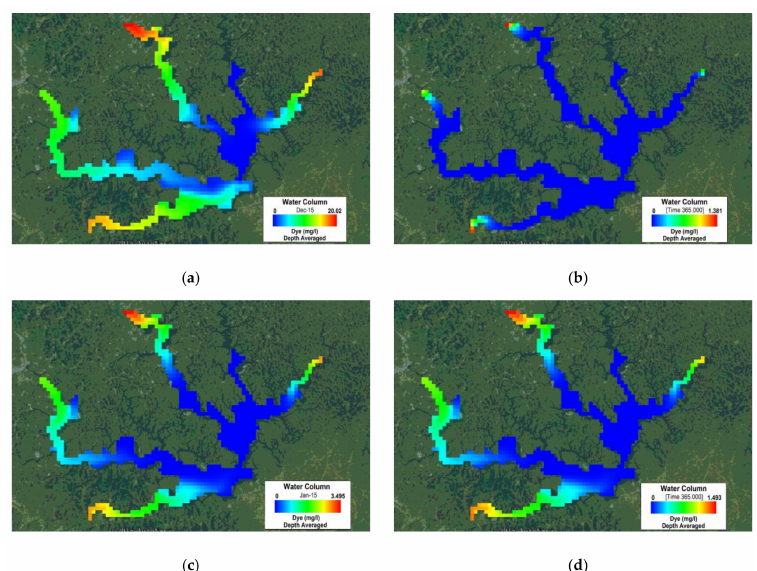
Figure 4. The simulated concentration distribution of COD, NH 3 -N, TN, and TP in the Huangshi Reservoir in 2020. (( a ) COD, ( b ) NH 3 -N, ( c ) TN and ( d ) TP).